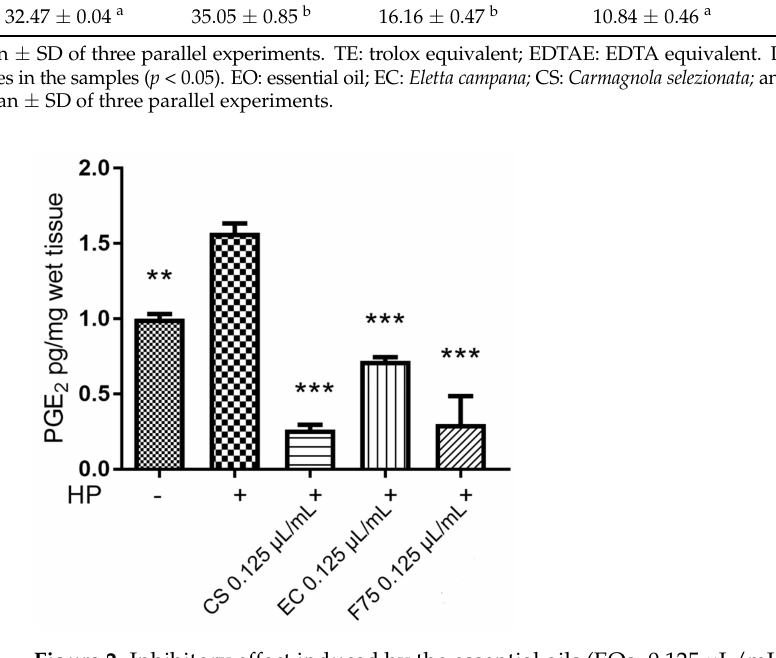
Figure 2. Inhibitory effect induced by the essential oils (EOs: 0.125 µ L/mL) of Carmagnola selezion- ata (CS), Eletta campana (EC), and Futura 75 (F75) cultivars on hydrogen-peroxide (HP)-induced prostaglandin E2 (PGE 2 ) level (pg/mg wet tissue), in isolated mouse skin specimens. ANOVA, p < 0.0001; ** p < 0.01, *** p < 0.001 vs. hydrogen peroxide (HP)